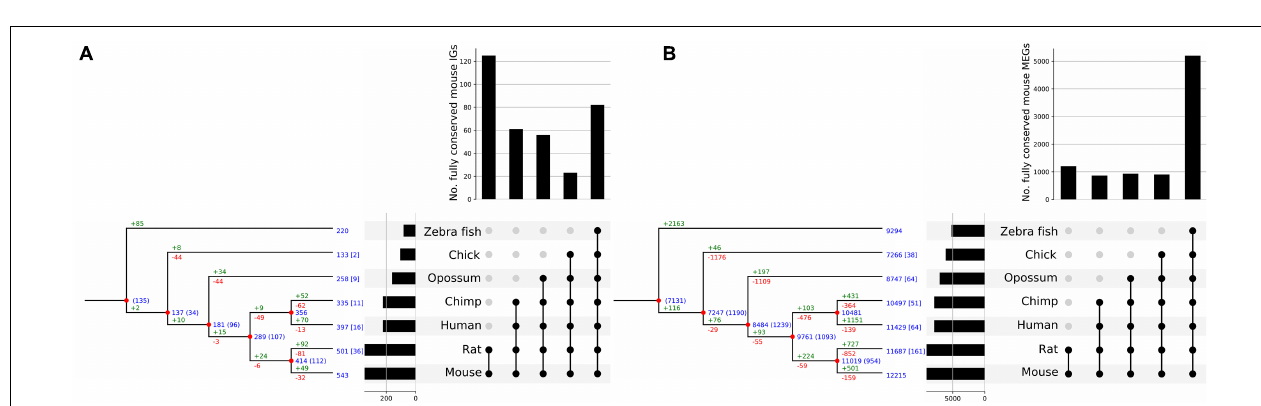
FIGURE 8 | Distribution of post-translational modifications in mouse IG proteins compared to MEG proteins. (A) PTMs with similar distribution between IG and MEG proteins. (B) PTMs exclusive to MEGs. (C) PTMs predominant in IG, and (D) in MEG proteins.